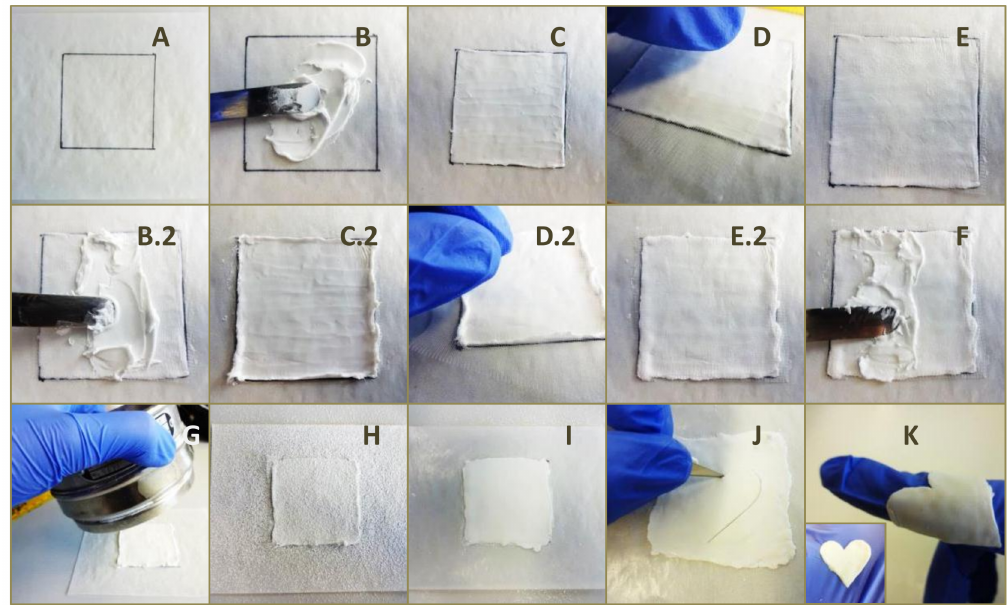
Figure 1. Manufacturing regime of prefabricated laminates using three layers of MEW PCL